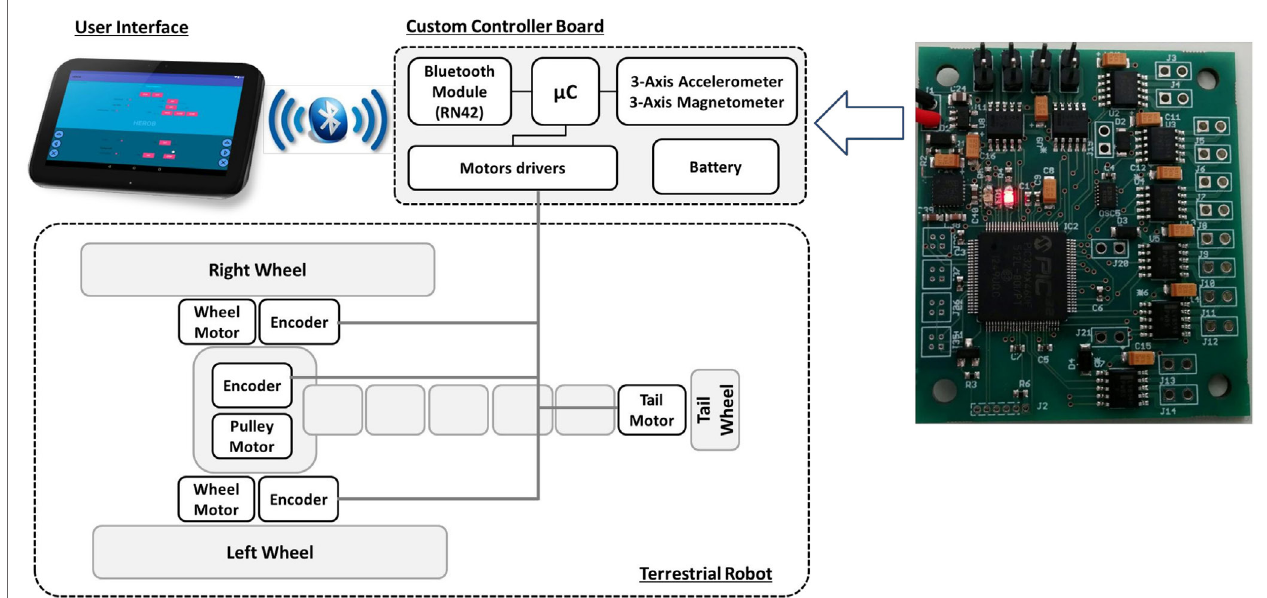
FigUre 5 | The architecture of control unit